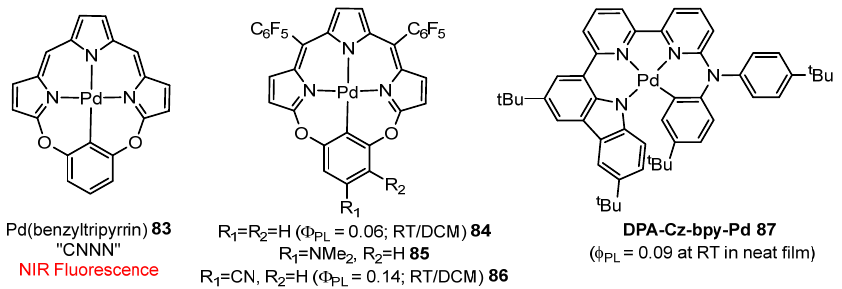
Figure 23. Pd(II) complexes 83 − 86 from tripyrrines and complex 87 , all of them showing NIR emis- sion. Adapted from